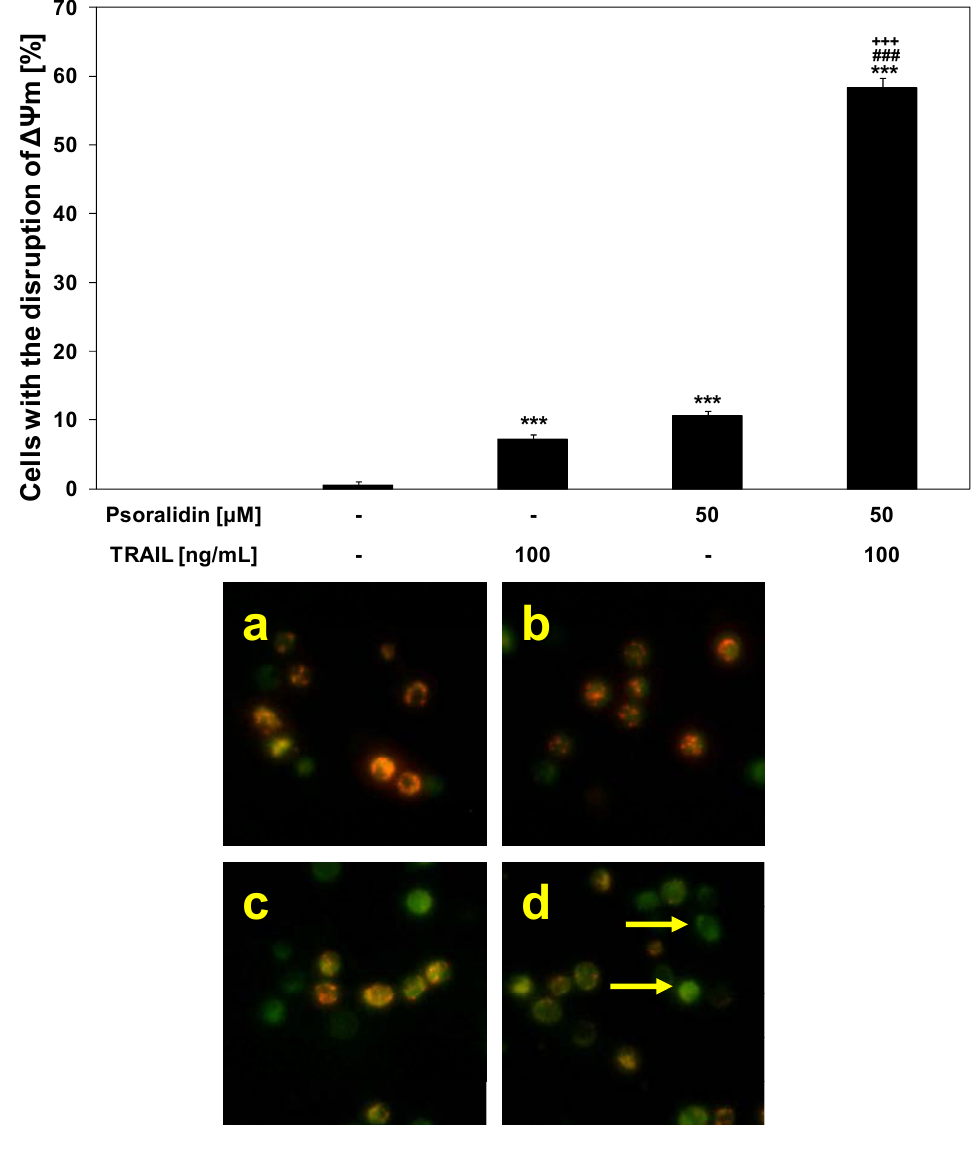
Figure 7. Effects of TRAIL in combination with psoralidin on the mitochondrial membrane potential ( ΔΨ m) in HeLa cancer cells. Cells were incubated for 48 h with TRAIL at the concentration of 100 ng/mL and/or psoralidin at the concentration of 50 μ M. The values represent the mean ± SD of three independent experiments performed in duplicate n = 3 ( *** p < 0.001 compared with control, ### p < 0.001 compared with Psoralidin and +++ p < 0.001 compared with TRAIL). TRAIL in combination with psoralidin induced loss of ΔΨ m in HeLa cells. Disruption of ΔΨ m in cancer cells was assessed by fluorescent microscopic analysis of DePsipher staining: ( a ) control cells; ( b ) cells incubated with TRAIL; ( c ) cells incubated with psoralidin; ( d ) cells incubated with TRAIL and psoralidin. Red fluorescence is emitted from the red aggregates of DePsipher, which are formed within mitochondria in healthy cells. Green fluorescence reveals the monomeric form of the DePsipher molecule, which appears in the cytosol after mitochondrial membrane depolarisation (indicated by